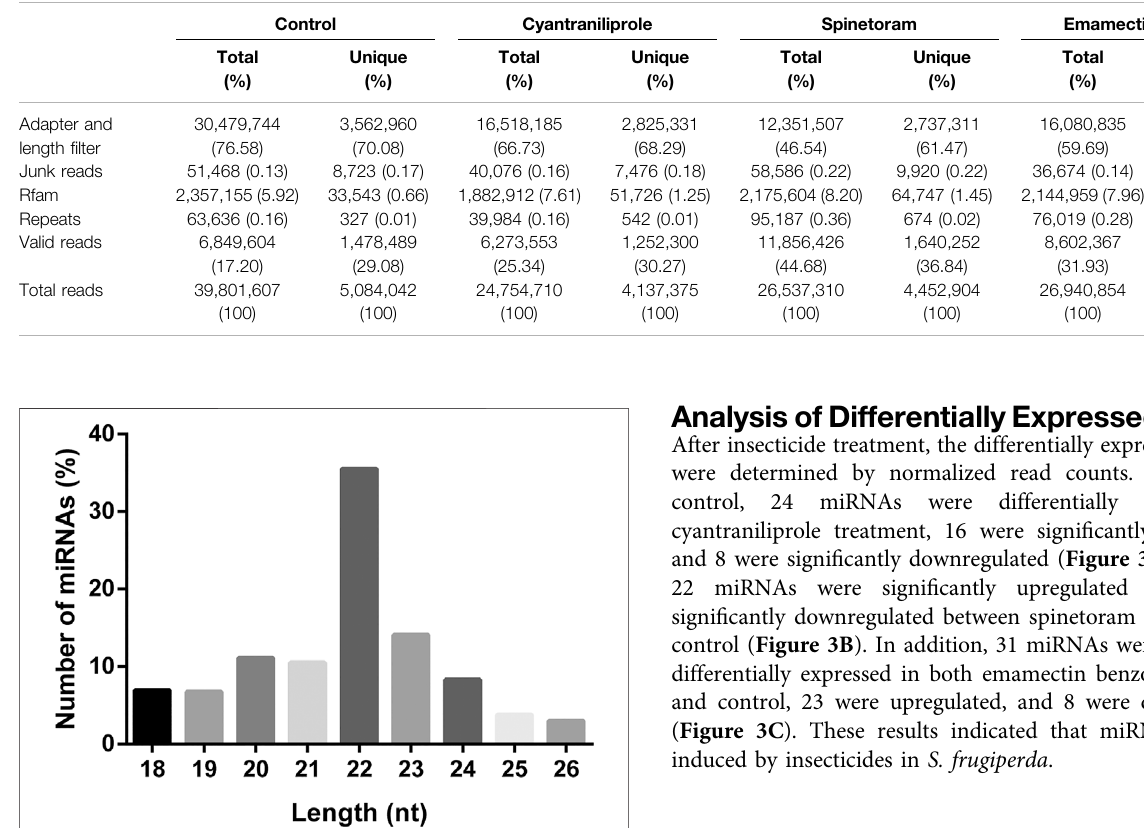
FIGURE 1 | Length distribution of miRNAs in S. frugiperda